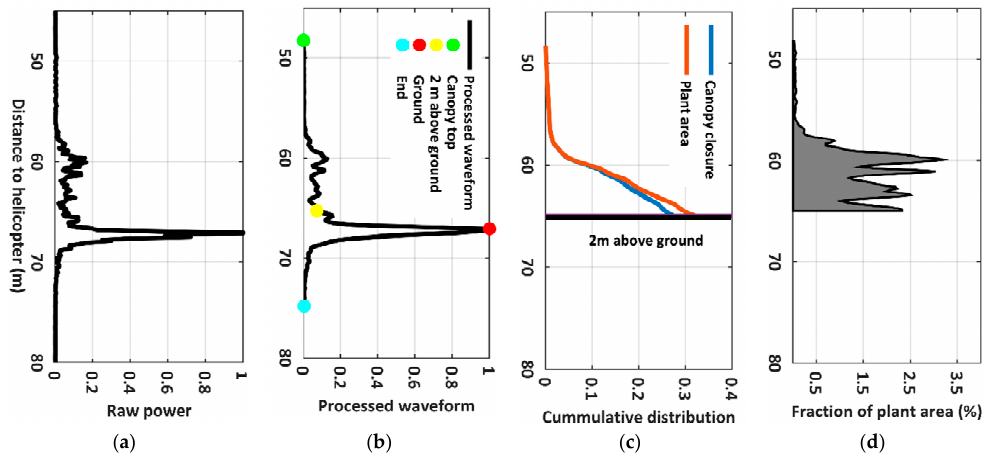
Figure 4. The processing steps of converting Tomoradar waveforms into the CHP: ( a ) raw power waveform with 15 cm range resolution; ( b ) processed waveforms by filtering noise, and the identified canopy top, 2 m above ground, center, and end of the ground; ( c ) the canopy closure profile and cumulative plant area; and ( d ) the incremental distribution of the plant area (CHP) at 2 m above ground.